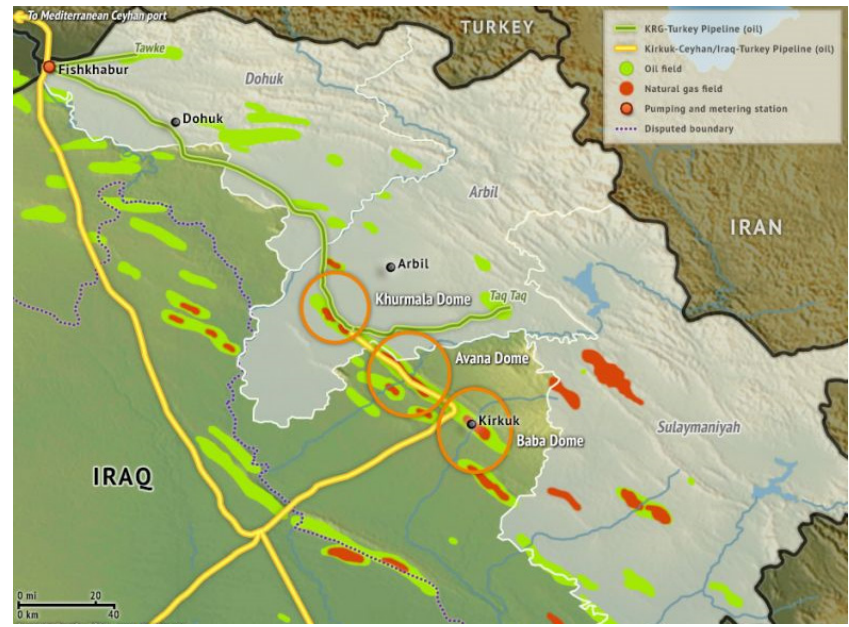
Figure 1. Illustration of the general location of oilfields in NE-Iraq. Close up the Baba Dome inside the lower circle shape.